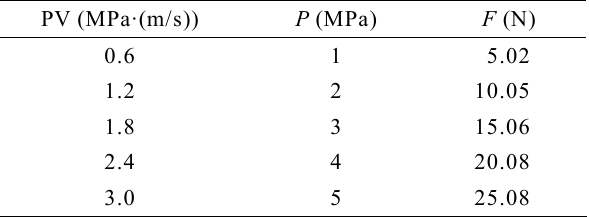
Table 3 Experimental design under the dry-friction conditions.